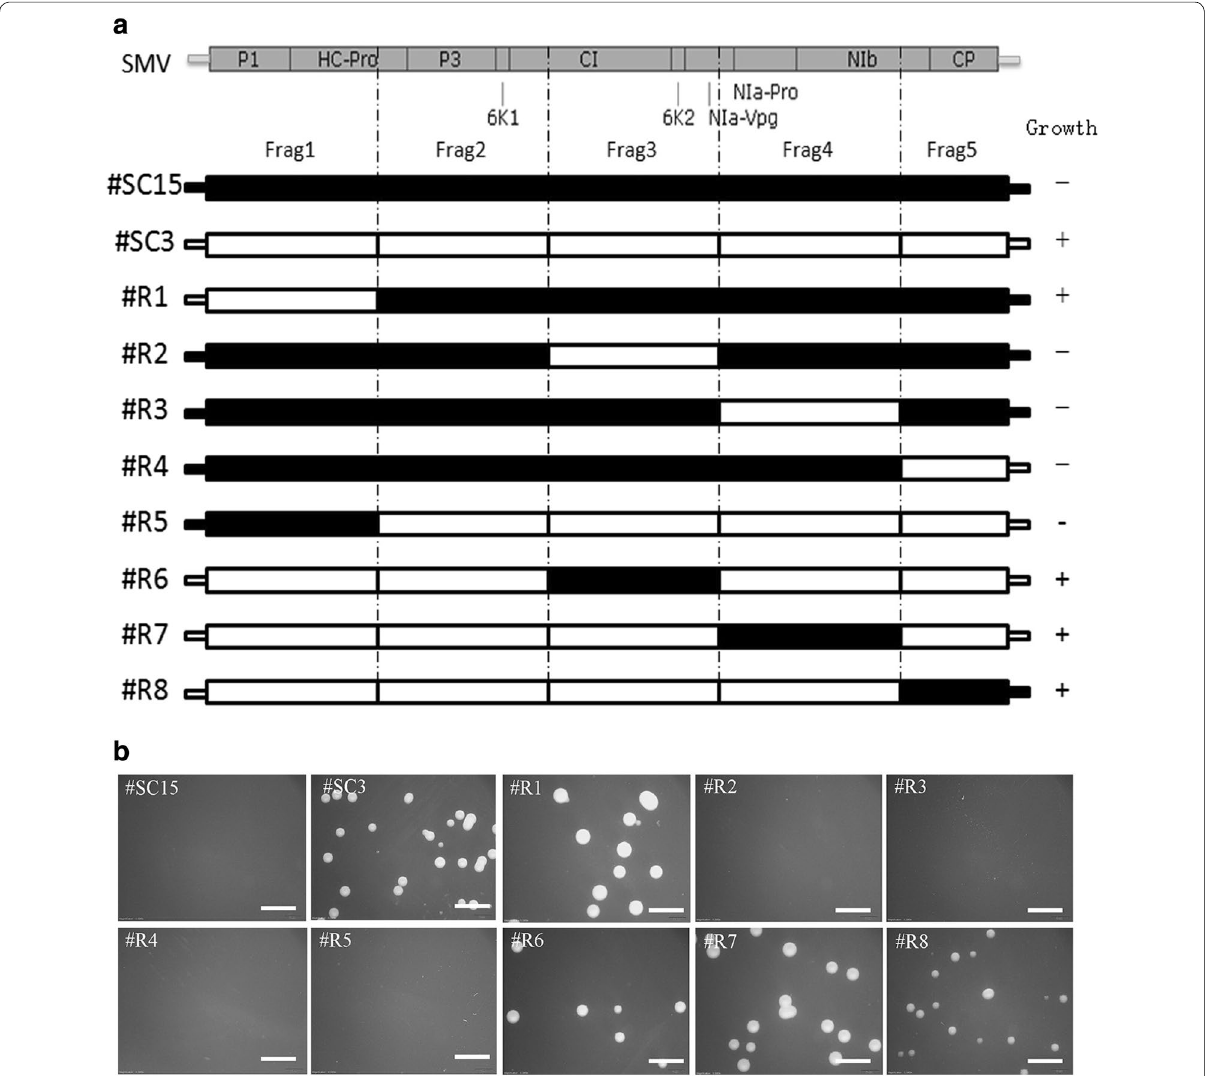
Fig. 2 Growth of Agrobacterium after transformation with the recombinant clones of #SC15 and #SC3. a The recombinant position of #SC15 and #SC3 and the growth of Agrobacterium after the transformation. “ “ ” indicates those not. b Photographs of Agrobacterium growth after the transformation of each recombinant clone. Scale bars −